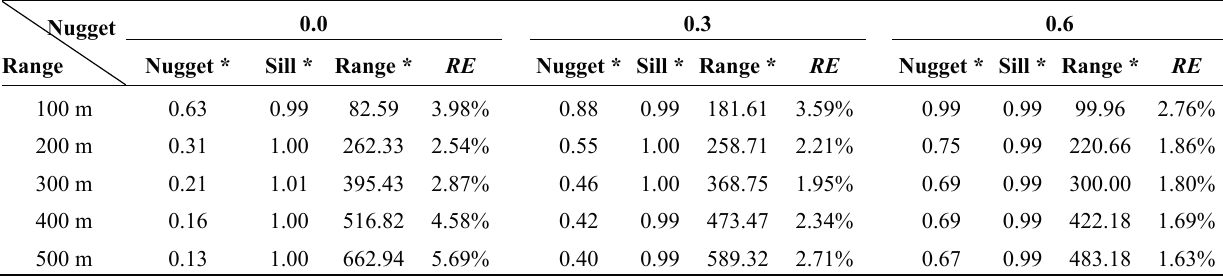
Table 2. Accuracy of parameter